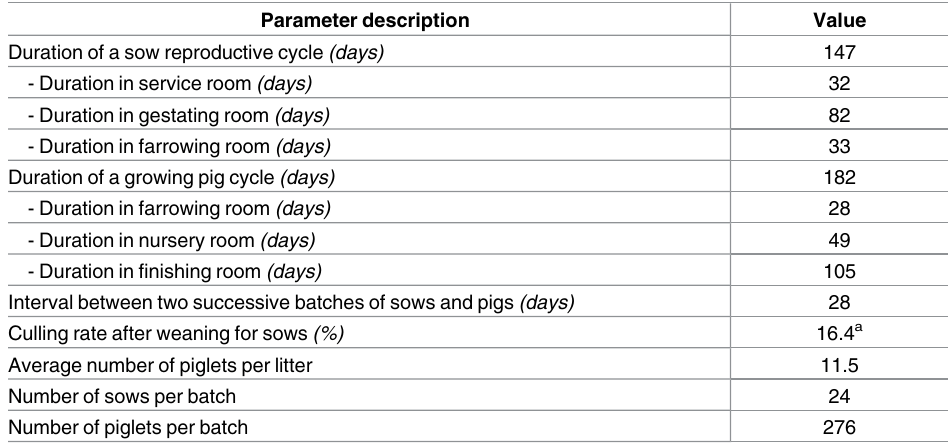
Table 1. Parameter values used in the metapopulation dynamics model reared in a 7-batch rearing system (from: [34,35]). Parameter description Value Duration of a sow reproductive cycle (days)